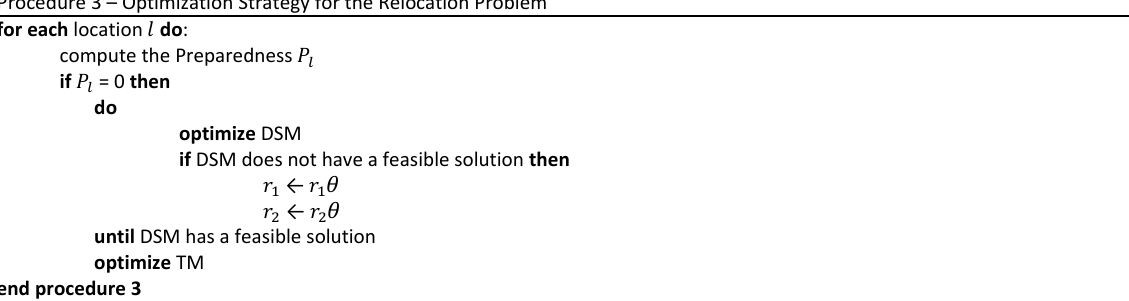
Procedure 3 – Optimization Strategy for the Relocation